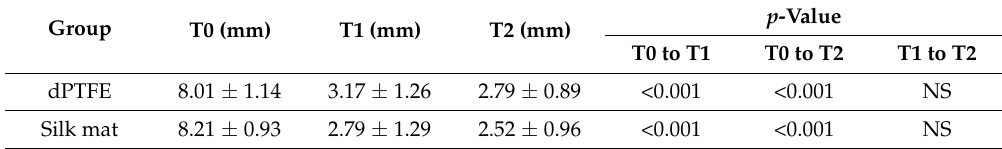
Table 2. Summary of clinical attachment level in patients who received membranes.